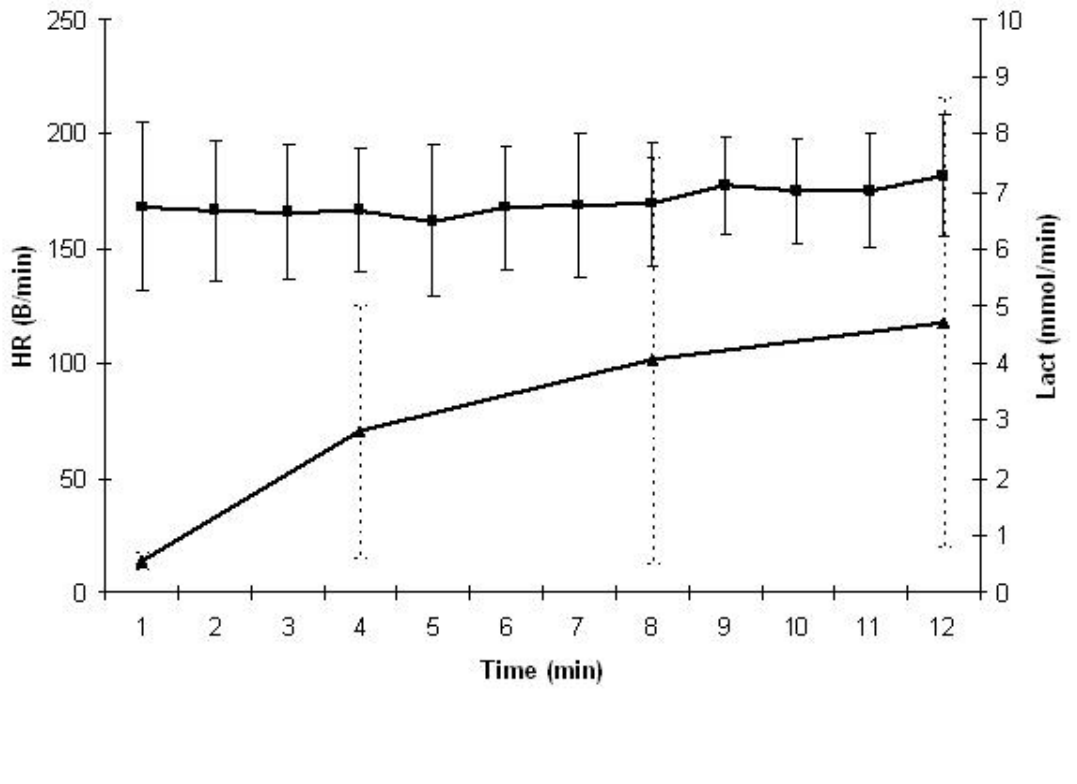
Figure 2. Average heart rate response and blood lactate response during the Cooper test (vertical bars indicate standard